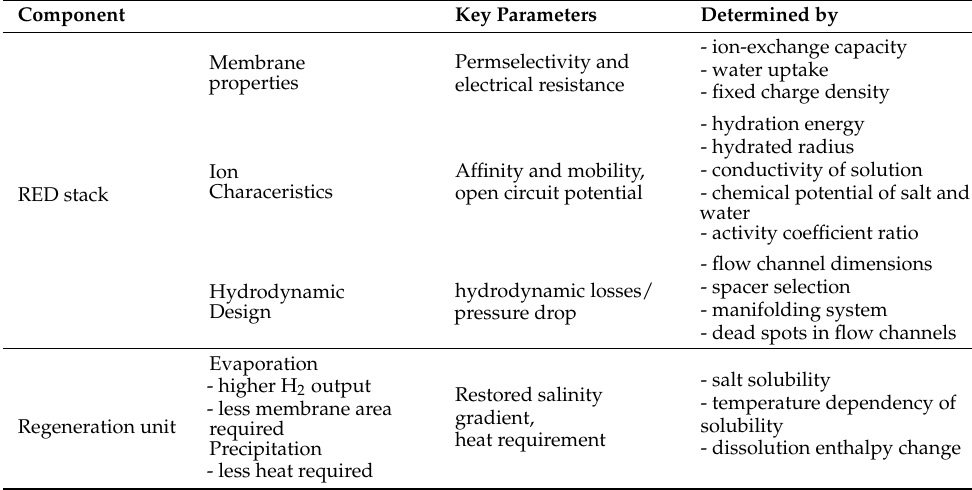
Table 6. Overview of the key parameters and characteristics for the REDHE